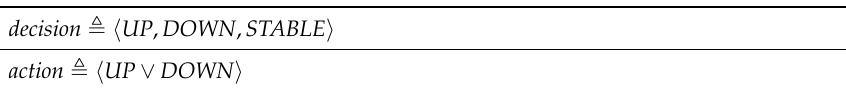
Figure 9. Envisioned protocol flow using the trained ML module. Table 4. Additional data